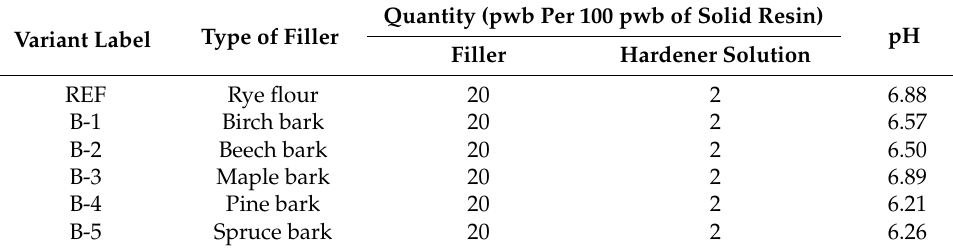
Table 1. Compositions of adhesive mixtures with various type of bark